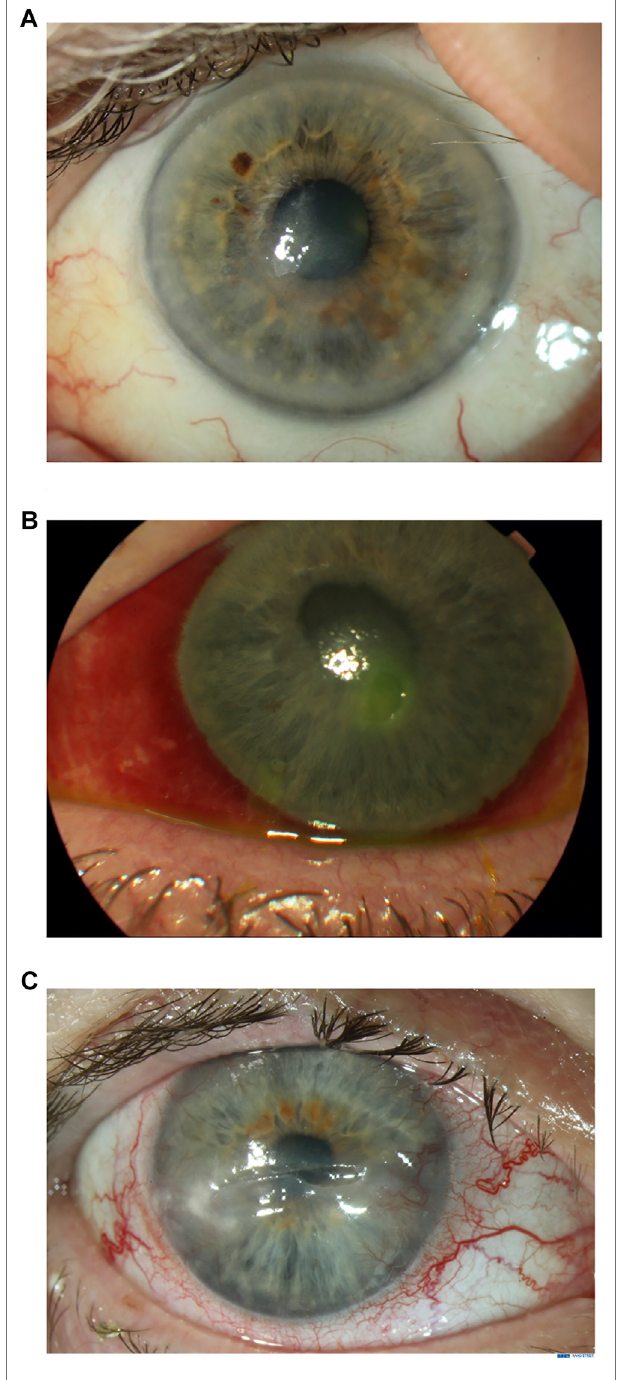
FIGURE1| Clinicalappearanceofneurotrophickeratitis(NK)stages1,2 and 3. Figure 1A . Stage 1 NK: Super fi cial opacity and punctate corneal epitheliopathy. Figure 1B . Stage 2 NK: Persistent epithelial defect. Figure 1C . Stage 3 NK: Ulceration with thinning to mid-stroma.